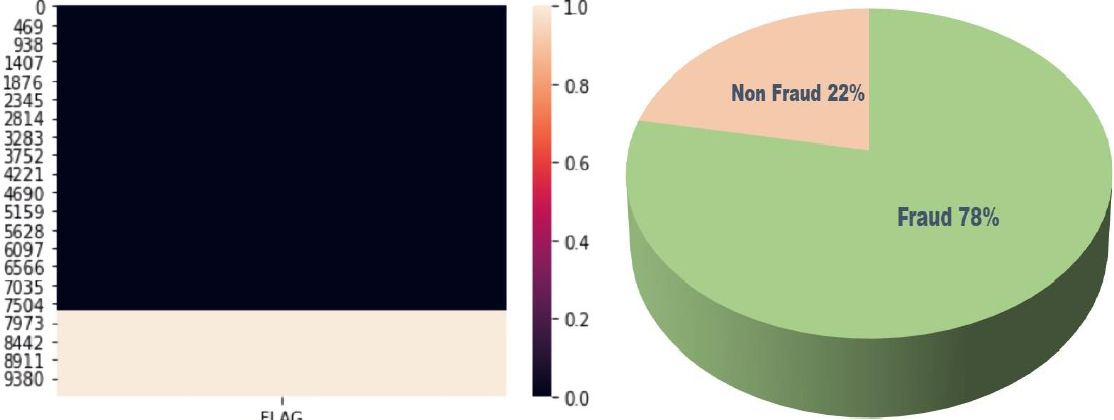
Figure 3. Ethereum classic dataset distribution having ‘1′ and ‘0′ was used and fraudulent value percentage.